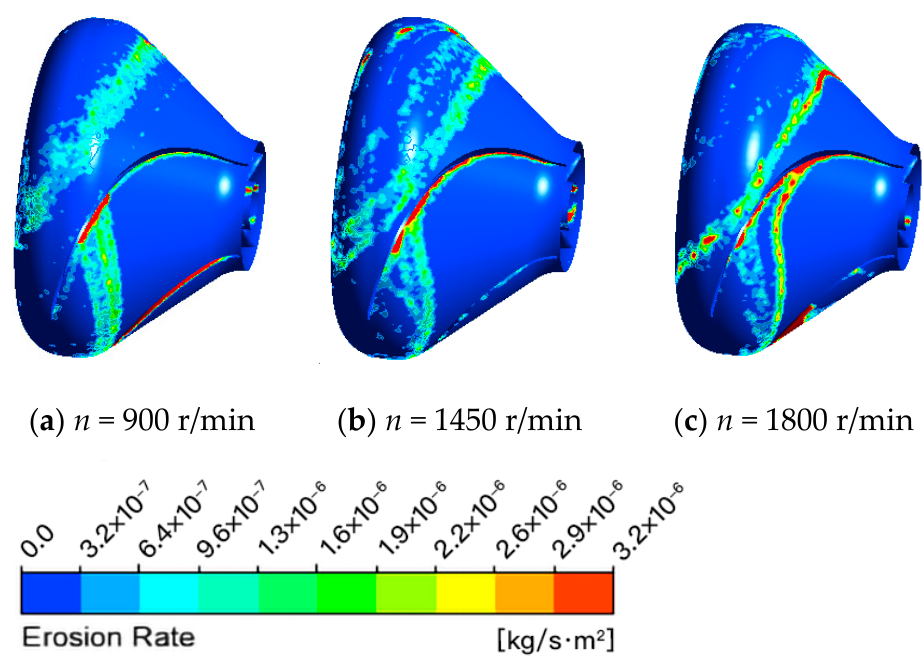
Figure 21. Wear distribution on the surface of the guide vanes.